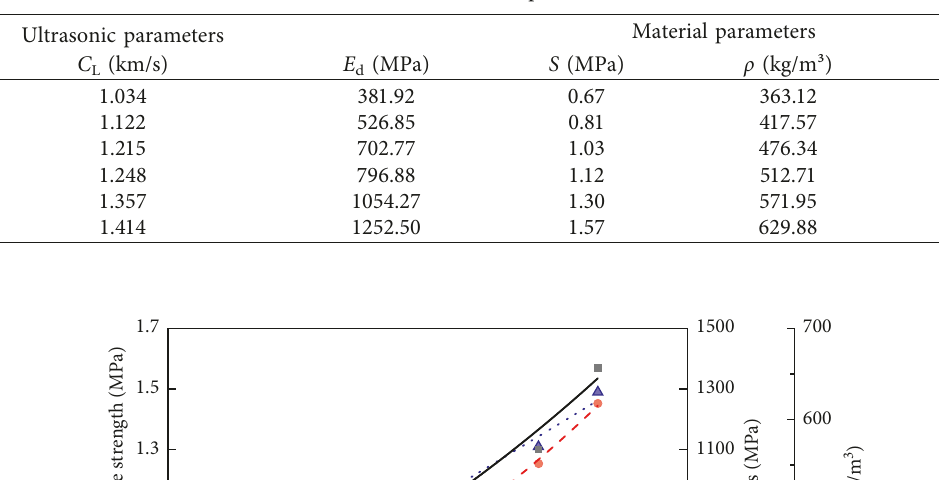
Table 4: Ultrasonic and material parameters of the FMLS.